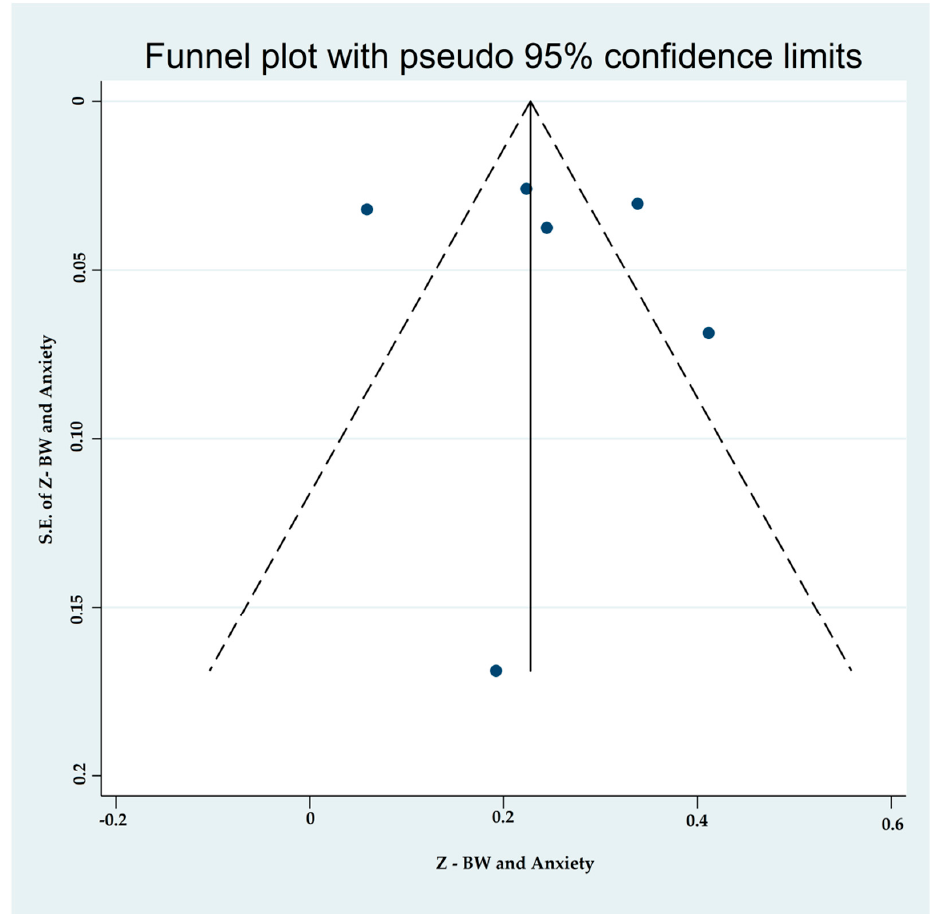
Figure 7. The funnel plot displaying the estimated pooled Fisher’s z-score in the association between binge-watching and anxiety.